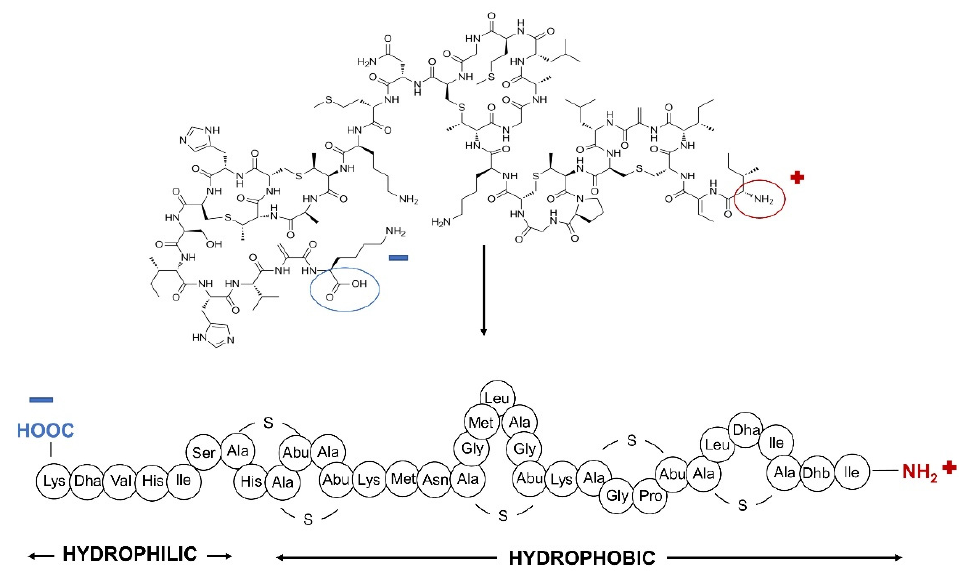
Figure 1. Chemical and primary structures of the nisin polypeptide.